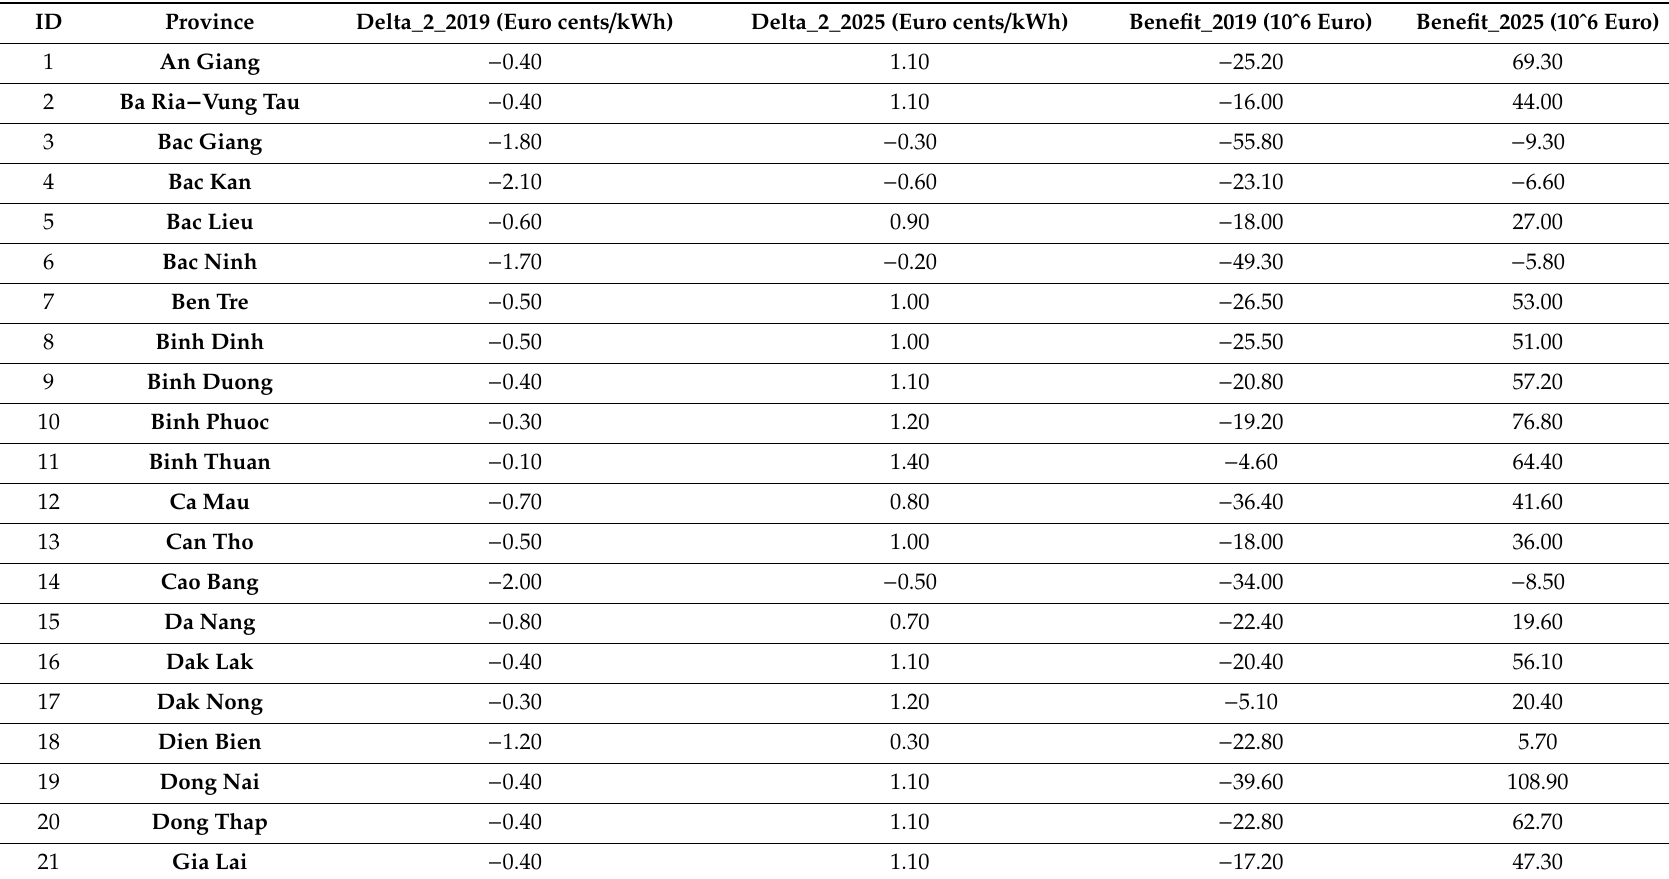
Table A6. Market benefit changes according to di ff erent grid tari ff